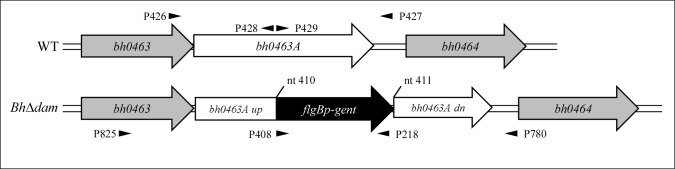
Schematic of the DNA adenine methyltransferase locus (bh0463A) in B. hermsii wild type (WT) and BhΔdam.The locations of primers used to generate pMTKO and verify BhΔdam are depicted as arrowheads (see Materials and Methods). nt, nucleotide; up, upstream sequence; dn, downstream sequence.